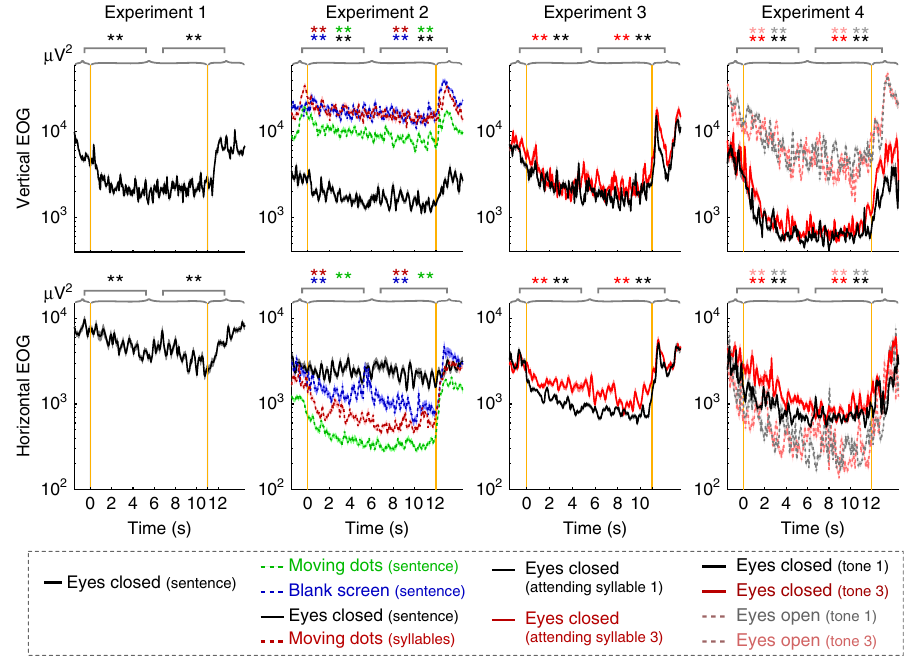
Fig. 7 Timecourse of the EOG power before, during, and after the stimulus. The vertical orange lines denote the onset and offset of the stimulus sequence. The upper and lower panels show vertical and horizontal EOG, respectively. The curves show the average of the single-trial EOG power, i.e., square of the EOG waveform. The solid and dashed curves show the eyes-closed and eyes-open conditions, respectively. Shaded area is 1 SEM across participants on each side. The EOG power is lower during the stimulus, compared with the pre-stimulus and post-stimulus periods (bootstrap, signi fi cance shown by stars in the same color as the lines, * P < 0.05, ** P < 0.01). See Supplementary Table 7 for the exact P -value, mean, and variance